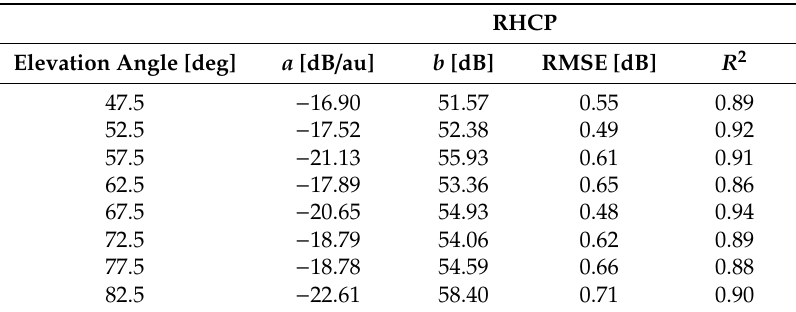
Table 1. RHCP C / N 0 vs. NDVI fitting parameters.